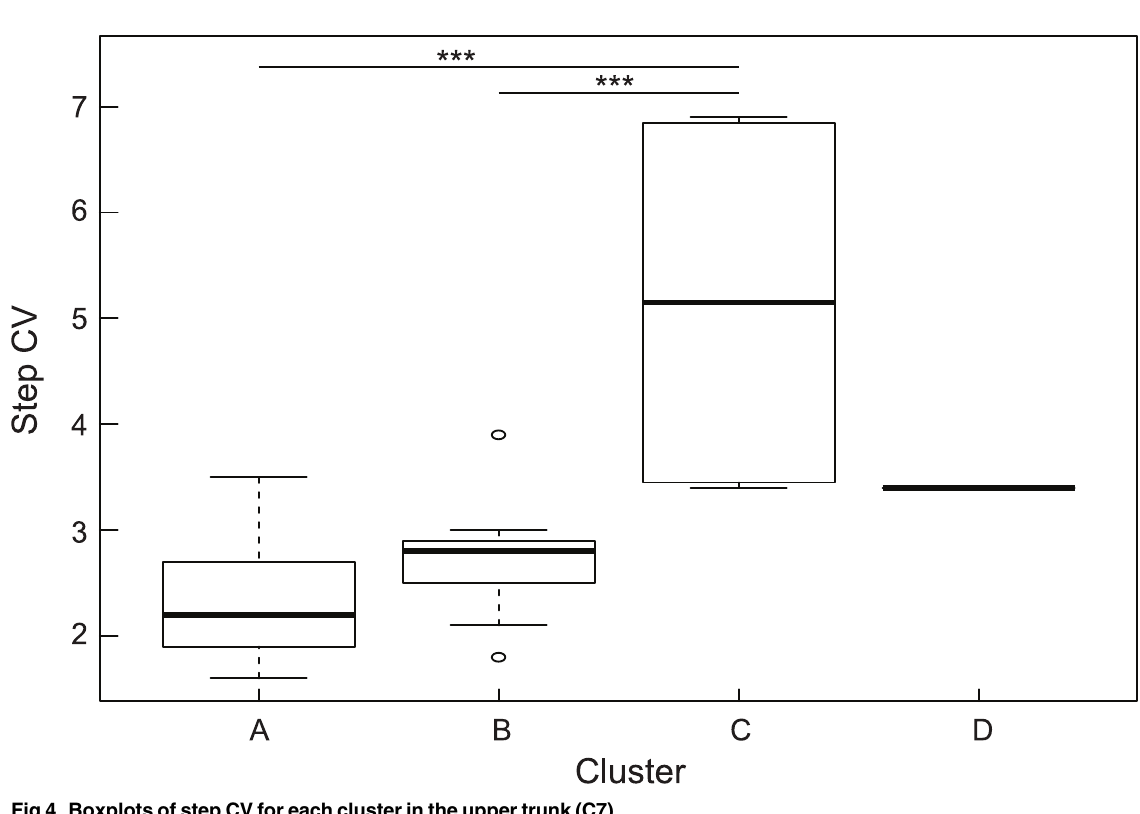
Fig 4. Boxplots of step CV for each cluster in the upper trunk